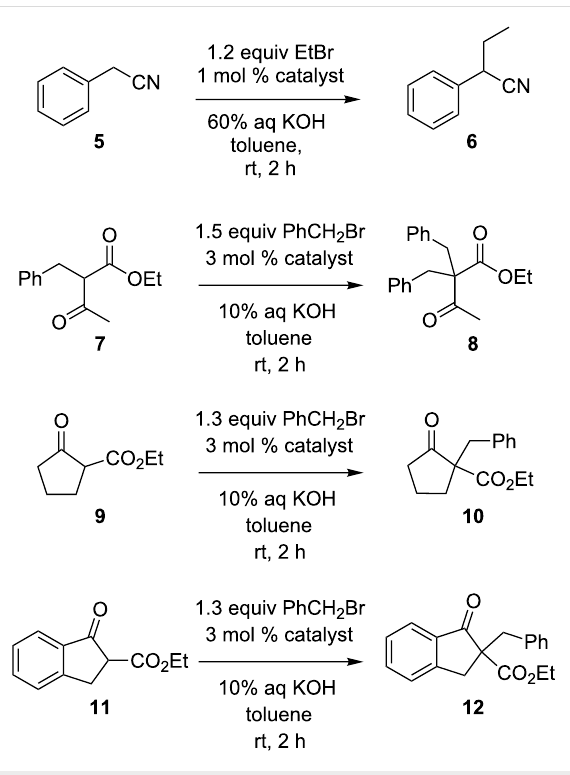
Scheme 6: Phase-transfer catalyzed alkylation reactions (see Table 1 for details).